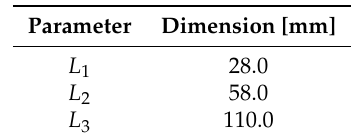
Table 4. Parameter dimensions of the hexapod’s